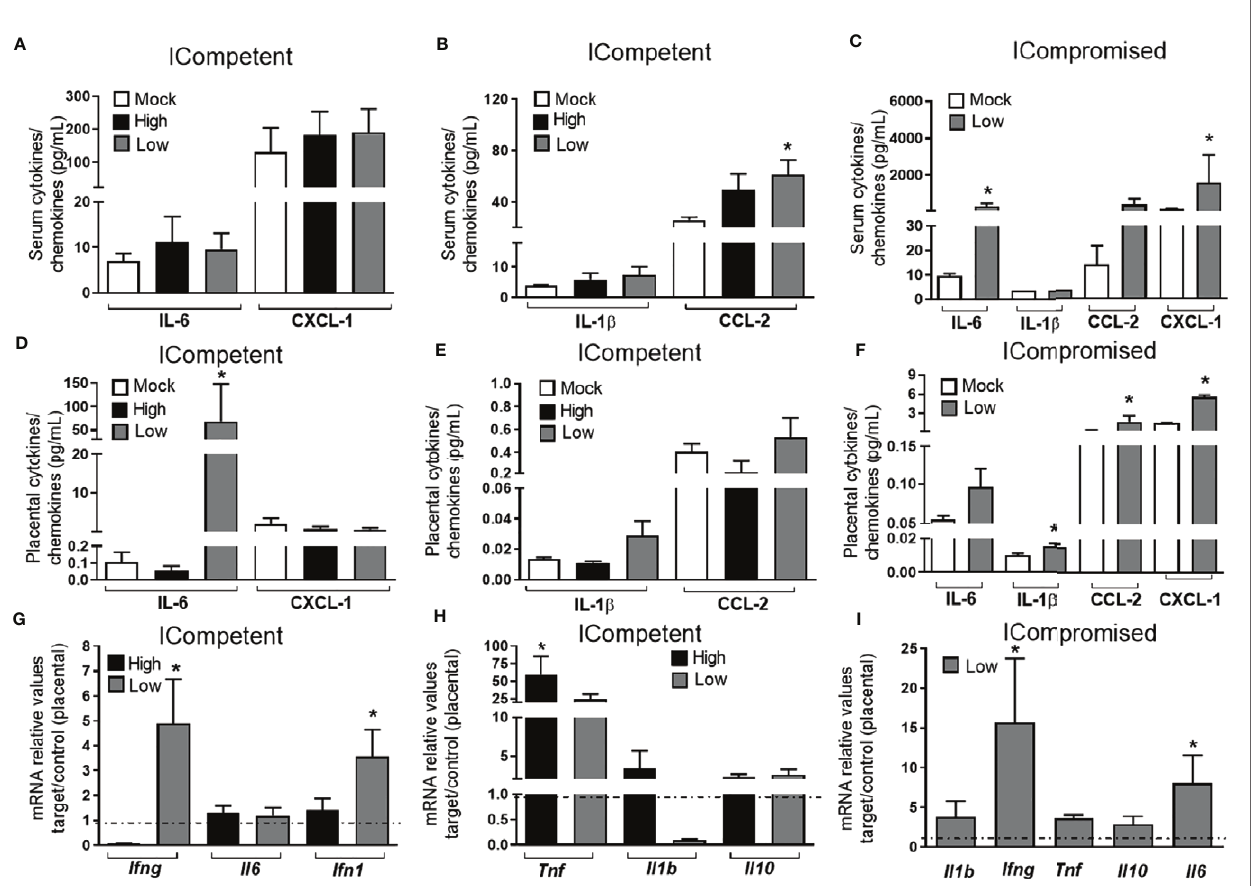
FIGURE 3 | ZIKV during pregnancy promotes an in fl ammatory response in the maternal serum and in the placenta. Levels of IL-1 b , IL-6, CCL-2 and CXCL-1 in the maternal serum (A – C) and placenta (D – F) at GD18.5 in matings of C57BL/6 dams x C57BL/6 sires (ICompetent fetuses - mock n=11 dams; high ZIKV n=15 dams; low ZIKV n=9 dams) and A129 dams x C57BL/6 sires (ICompromised fetuses n=3 dams/group). Placental mRNA expression (G – I) of Ifng , Ifn1, Il1b, Il6, Il10 and Tnf . Broken lines show the expression levels in both lineages in the mock group. One-way ANOVA followed by Tukey ’ s posttest was used to assess changes among ICompetent groups, whereas an unpaired Student ’ s t-test or nonparametric Mann-Whitney test was used to assess differences between ICompromised groups. The values are expressed as the mean ± SEM. *P <